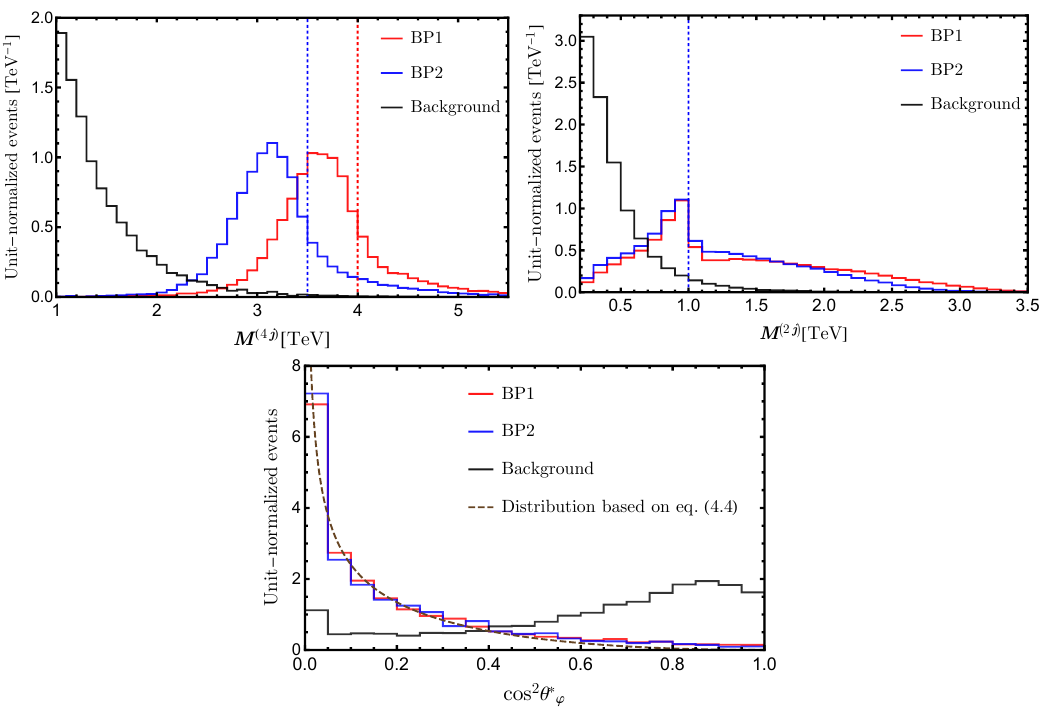
Figure 6 . Top left: Unit-normalized M (4 j ) distributions of BP1 (red) and BP2 (blue) in SR I and the QCD 4-jet background (black). The red and blue dotted lines mark the input masses of KK graviton for BP1 and BP2, respectively. Top right: Unit-normalized M (2 j ) distributions of BP1 (red), BP2 (blue), and the background (black). For each event, all 6 possible dijet invariant masses have been included. The dotted line marks the input mass of radion. Bottom: Unit-normalized cos 2 θ ∗ distributions of BP1 (red), BP2 (blue), and the background (black). The brown dashed line ϕ shows the theoretical expectation for the signal as described in eq.